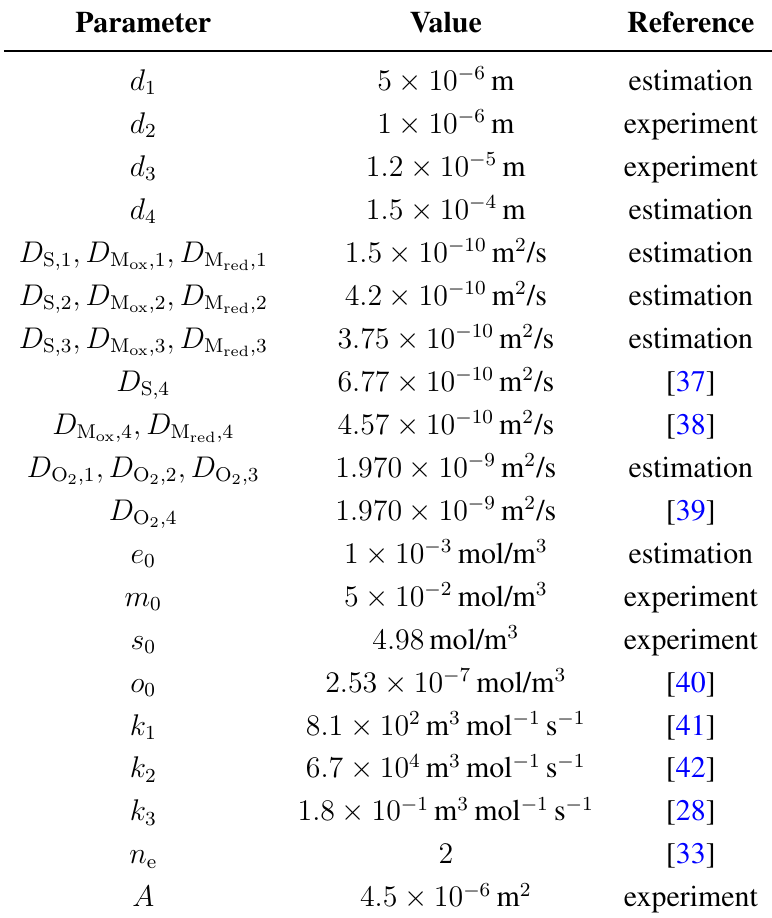
Table 1. The parameters of the